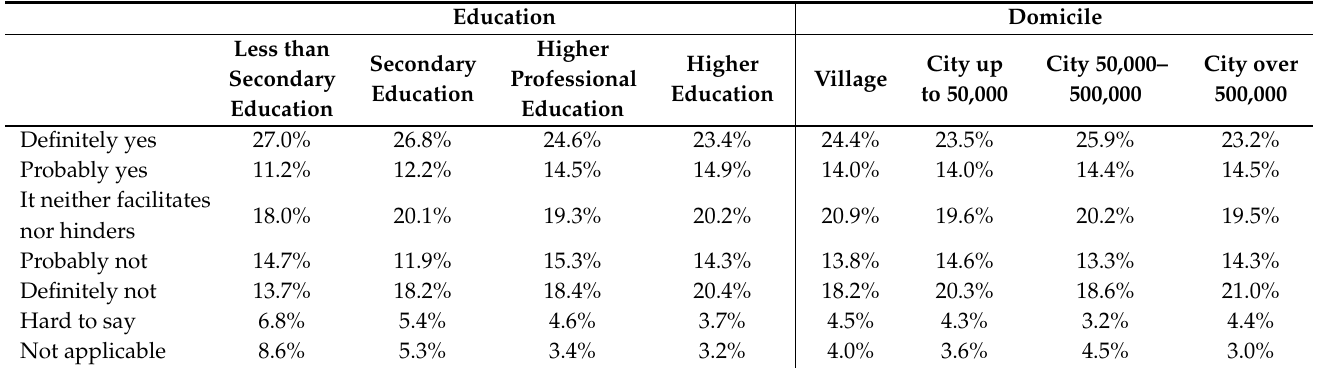
Table 1. Assessment of the organization of the work of a school or other care and educational facility to facilitate combining professional work with caring for a child/children (education and domicile) (n =